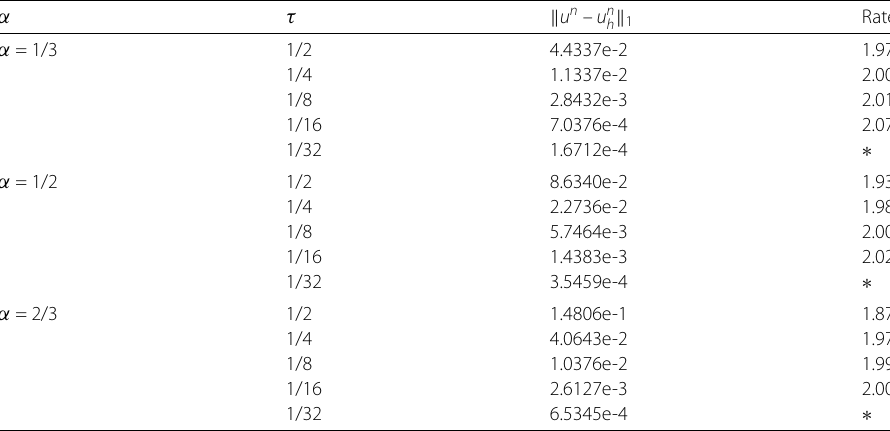
Table 1 Numerical errors and convergence orders in temporal direction with h = π Example 1